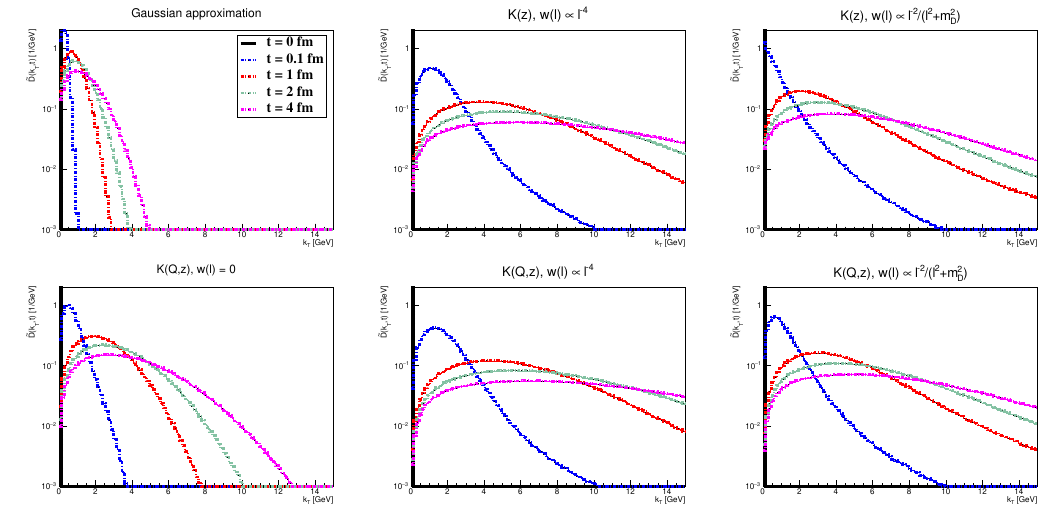
Figure 2 . The k T distributions for the evolution time values t = 0 , 0 . 1 , 1 , 2 , 4 fm, for different kernels: the Gaussian approximation, K ( z ) and K ( Q , z, p + ) (denoted as K(Q , z) ), and different collision terms: no collision term, the collision term as in eq. (2.6) and as in eq.